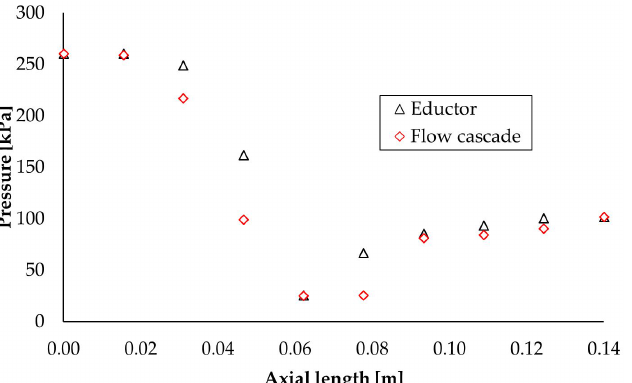
Figure 12. The pressure distribution between eductor and cascade for the analogy of the study.